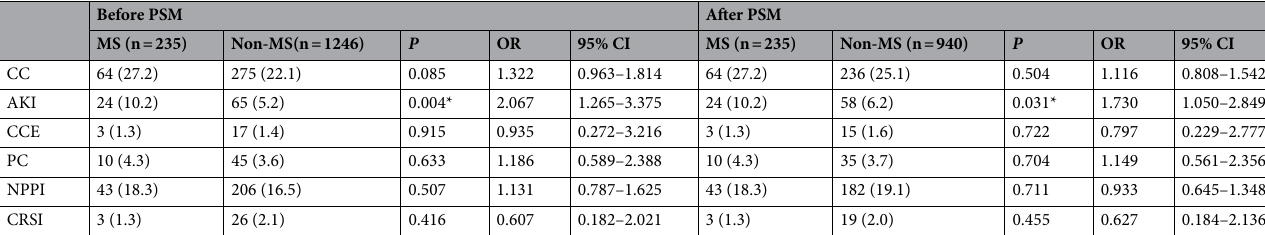
Table 3. Components of Composite complications after open pancreatic surgery. * P value was less than 0.05, with statistical significance. MS Metabolic syndrome, PSM Propensity score matching, Non-MS Non-metabolic syndrome, CC Composite complications, AKI Acute kidney injury, CCE Cardiovascular and cerebrovascular event, PC Pulmonary complications, NPPI Non-pulmonary postoperative infection, CRSI Complications requiring surgical intervention.